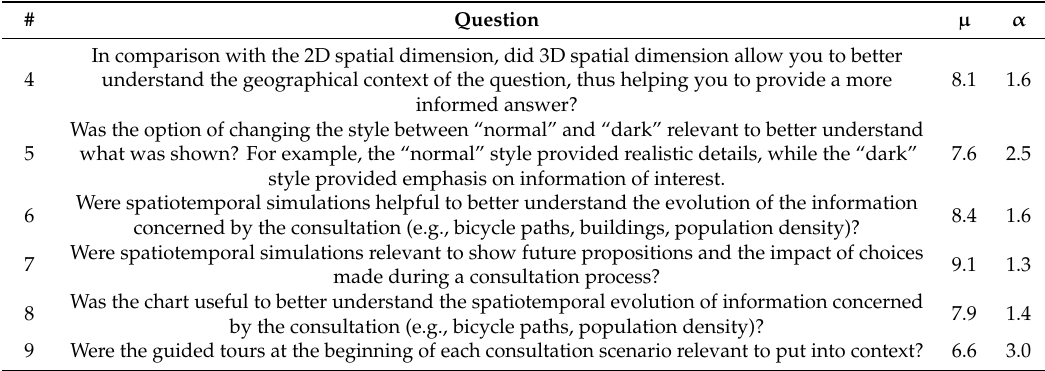
Table 1. Questions with associated mean ( µ ) and standard deviation ( α )